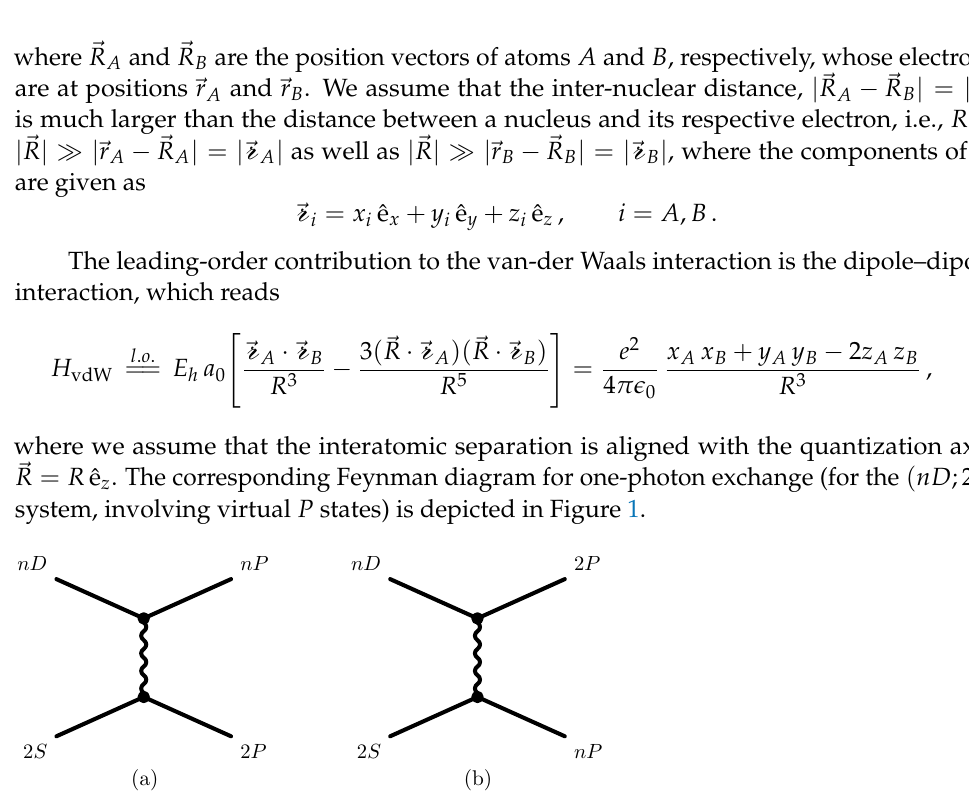
Figure 1. Feynman diagram for the one-photon exchange interaction within the quasi-degenerate basis of the nD and 2 S atoms. There are two combinations of final states possible within the manifolds of quasi-degenerate states investigated here, as evident from ( a , b ). Both processes are taken into account in our formalism. For n = 3, the displayed diagrams constitute all diagrams relevant to the 1/ R 6 interaction; for n = 8, there are two further diagrams where the nP states is replaced by an nF state. This is explained in further detail in Section